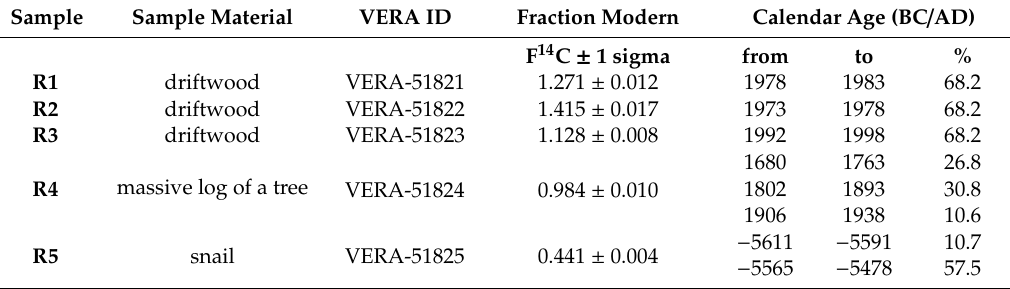
Table 1. Radiocarbon data for wood and snail samples. The time ranges of the calibrated ages correspond to 68.2%